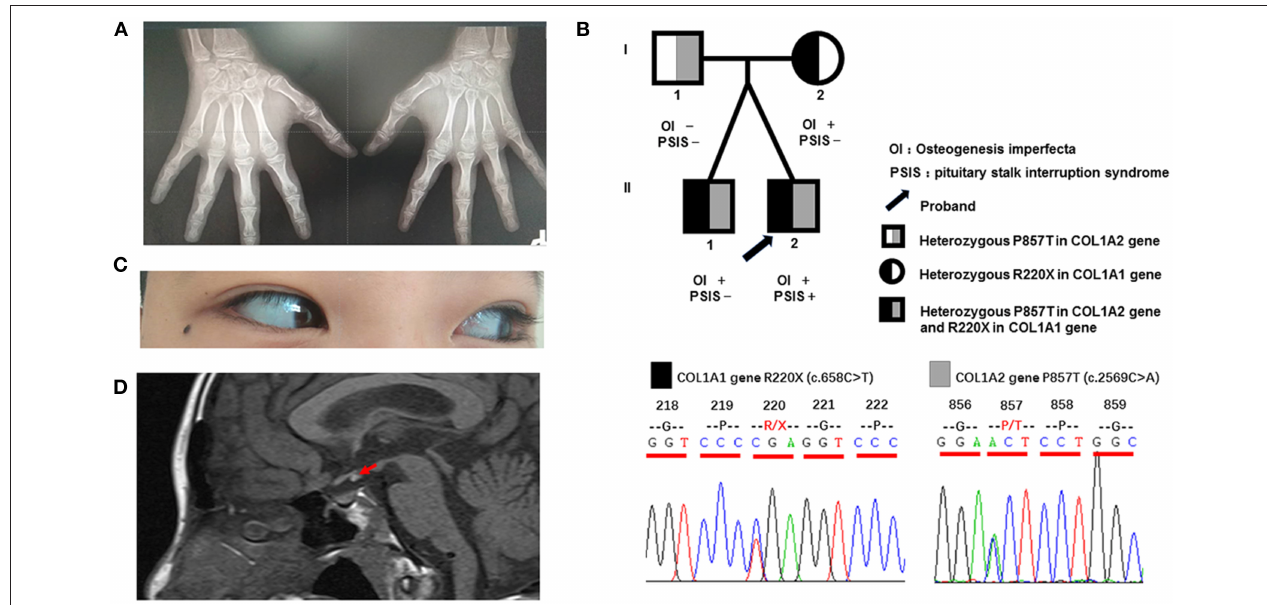
FIGURE 1 | Clinical characteristics and gene sequencing results of the patient and his family members. (A) Digital radiography of the hands. The phalanges and humeral metaphysis are fused, indicating an age of 14–15 years. (B) Pedigree of the patient and gene sequencing results. The father is a heterozygous carrier of the P857T mutation in the COL1A2 gene. The mother is a heterozygous carrier of the R220X mutation of the COL1A1 gene. The twin brothers are heterozygous carriers of the above two mutations. (C) Light blue sclera of the patient. (D) Magnetic resonance imaging of the pituitary of the patient, indicating reduced morphology of the anterior lobe, absence of the pituitary stalk, and displacement of the neurohypophysis to the infundibulum (red